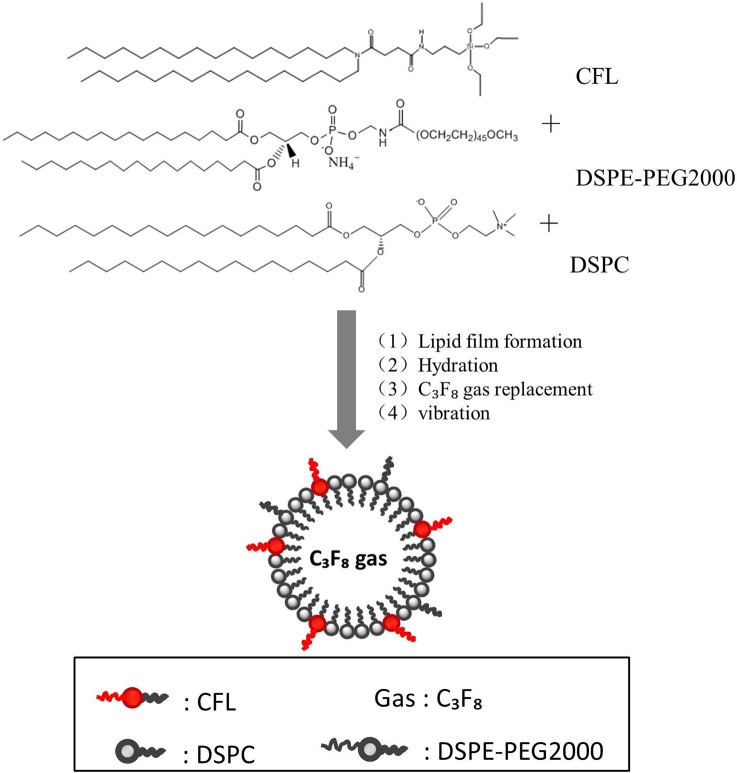
Schematic illustration of the procedure for fabrication of SNBs.Three formulations contained different amounts of CFL.